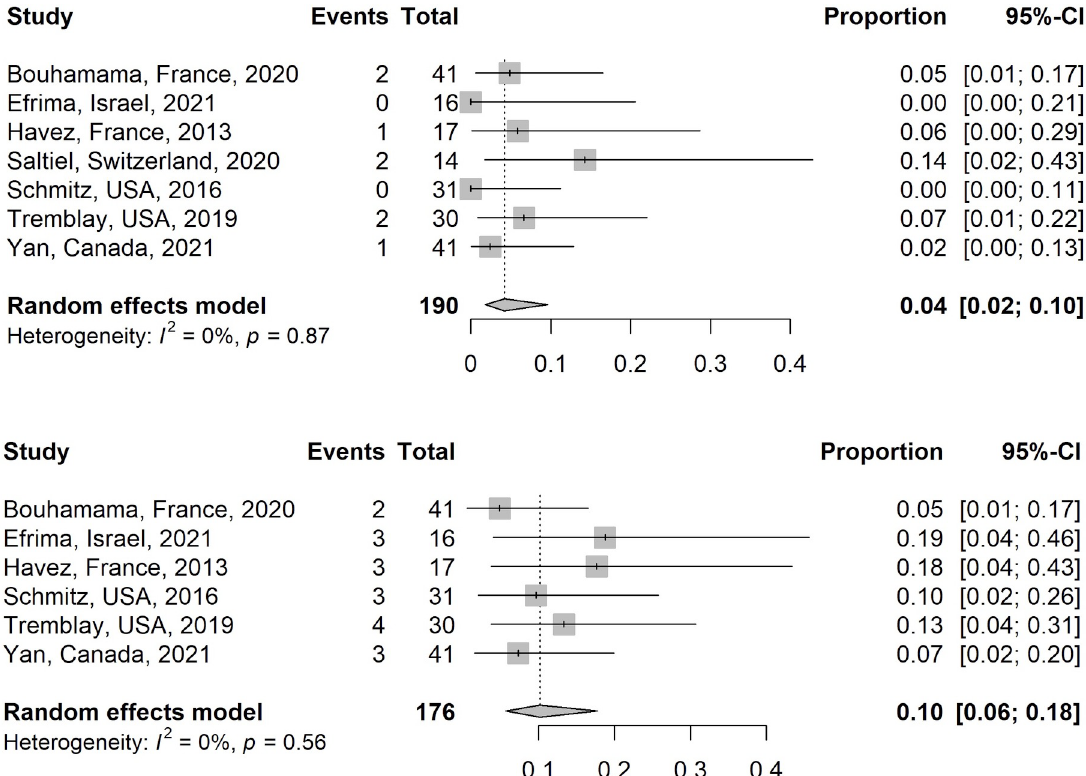
Fig 3. Comparison of the major (Fig 3A) and minor (Fig 3B) complications across the selected studies.